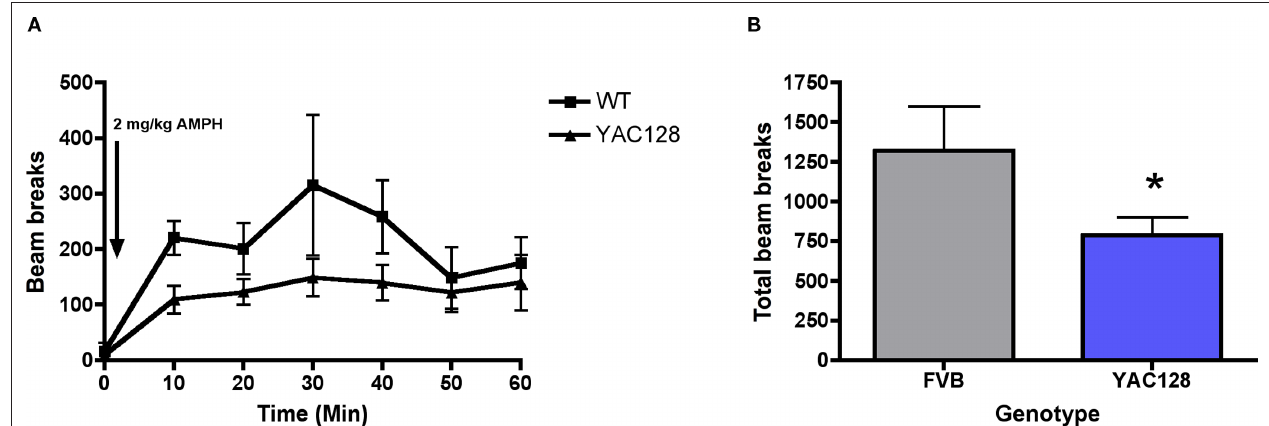
Figure 8 | effect of systemic injection of amphetamine (2 mg/kg; injection indicated by arrow) on (A) 10 min bins of locomotor activity and (B) the total beam break counts during a 60-min period in 7-month-old YAC128 transgenic mice ( n = 5 WT, 6 YAC128). * Indicates significantly different from WT, P